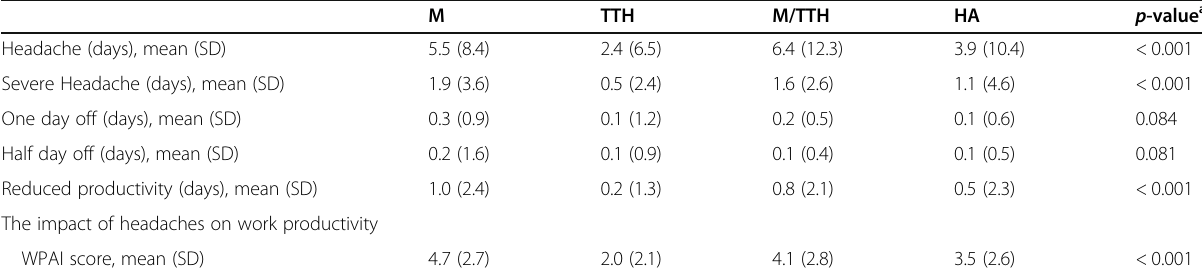
Table 3 Number of headache days and working days affected by headache in 3 months, and the impact of headaches on work productivity by